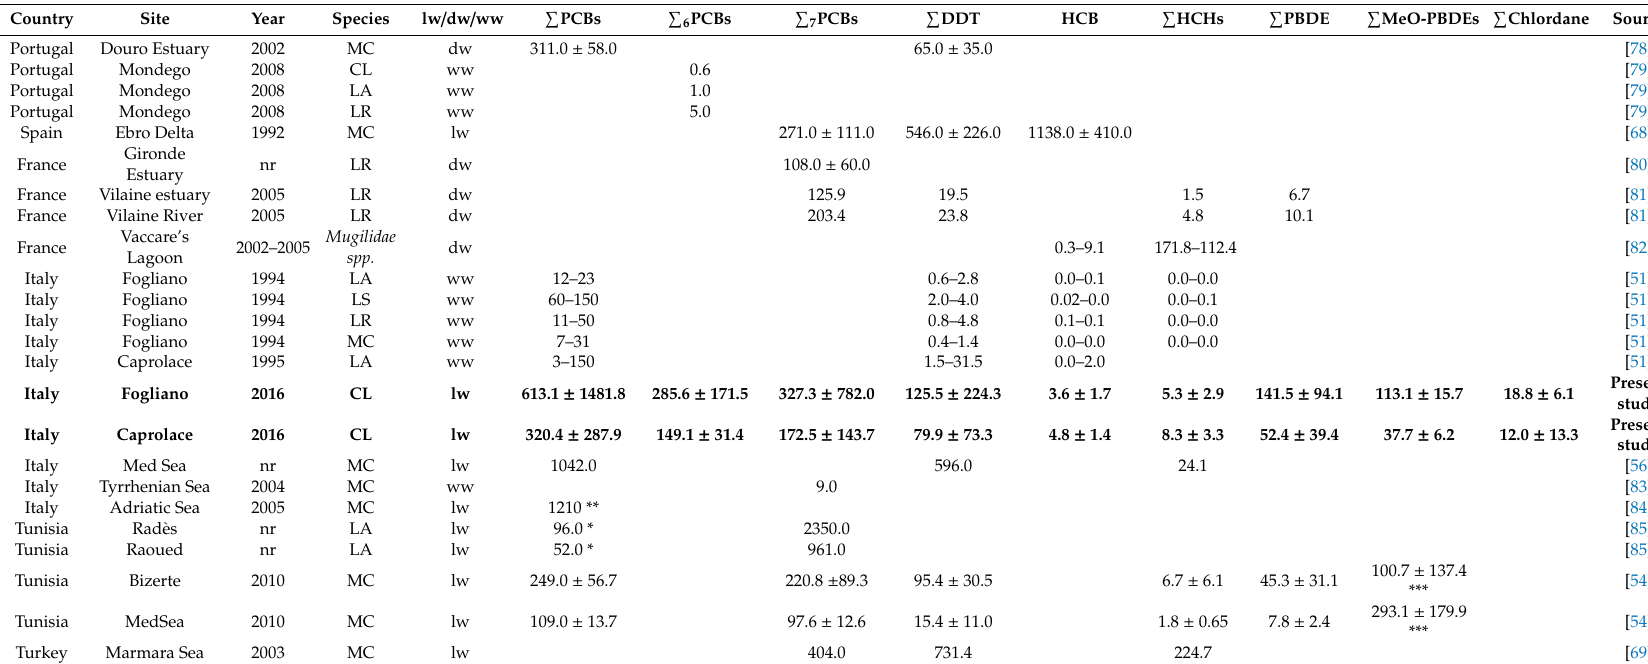
Table 4. Concentration of organochlorine compound ranges or mean values ( ± SD where available) (ng g − 1 ) in grey mullet (Mugilidae) muscle tissue available in the scientific literature of other Mediterranean locations, in the Atlantic coast of Europe and from the present study.